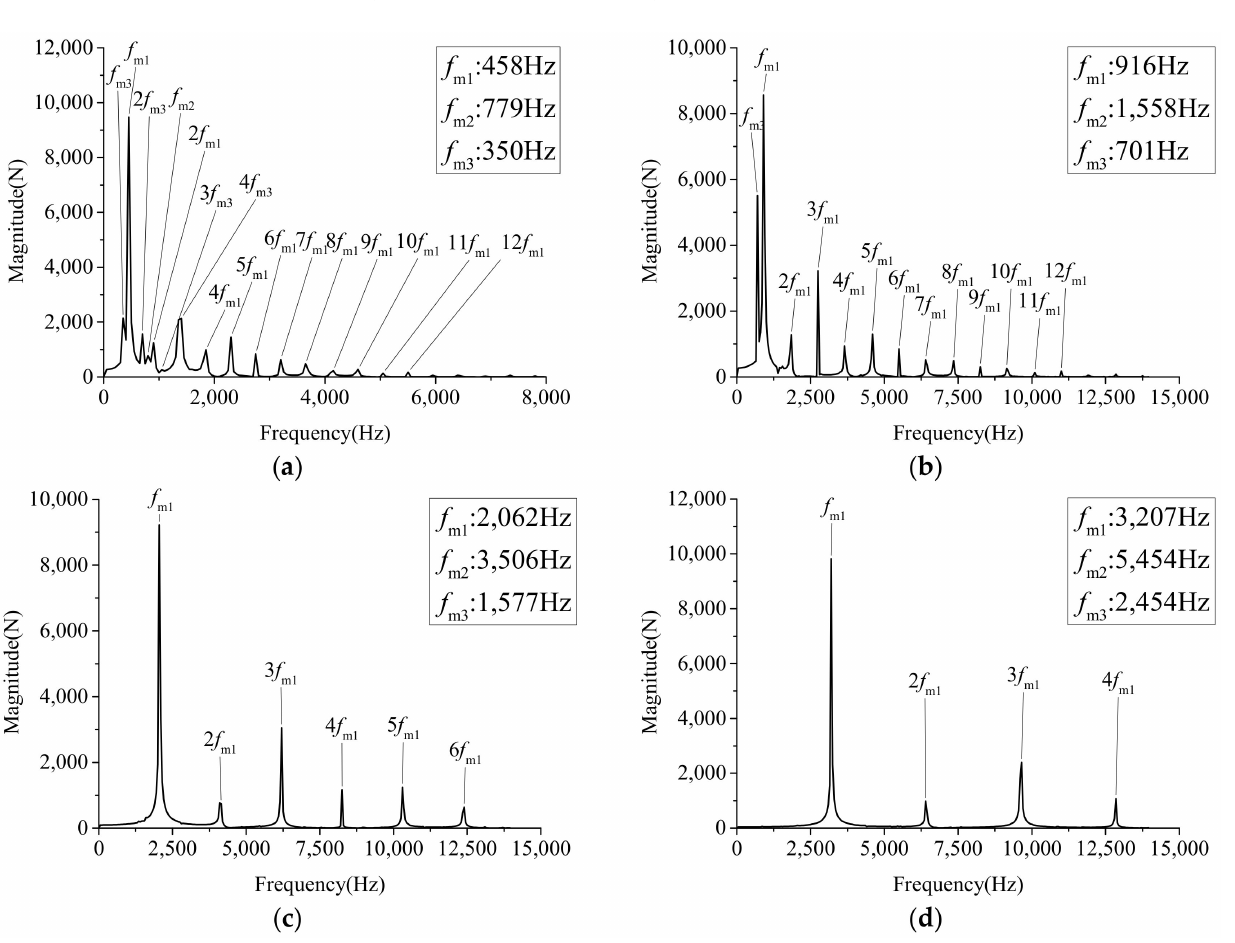
Figure 12. Spectrums diagram of meshing force of the first gear set at each input speed. ( a ) 1000 r/min; ( b ) 2000 r/min; ( c ) 4500 r/min; ( d ) 7000